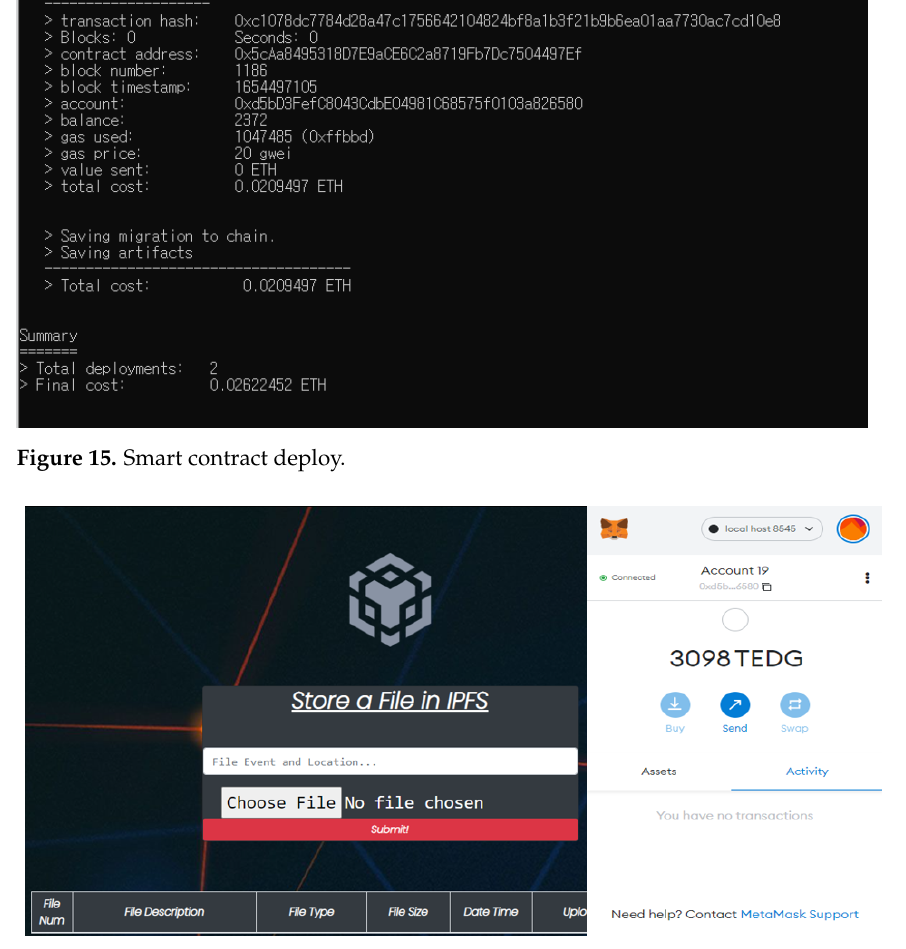
Figure 16. Connecting Metamask to the